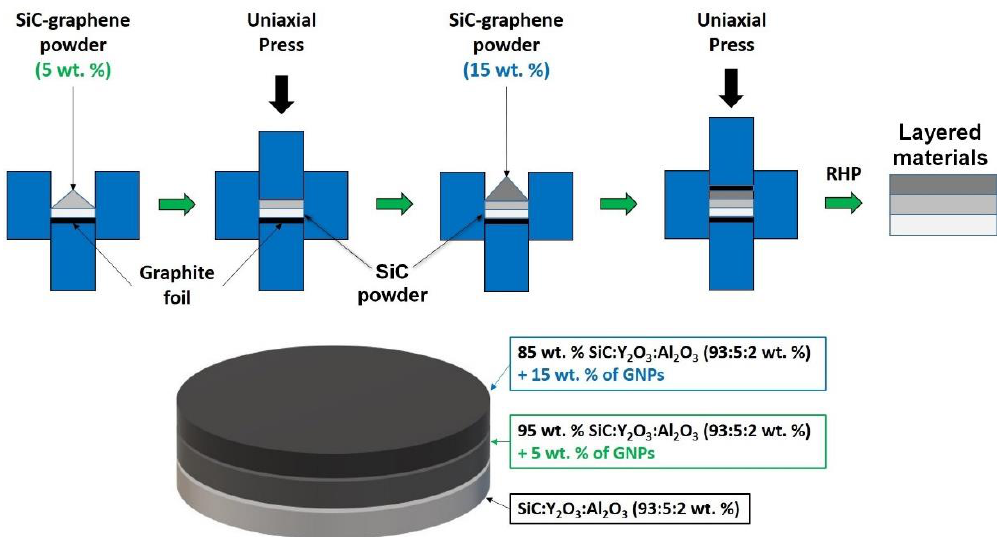
Figure 1. Schematic illustration of the preparation of layered materials.